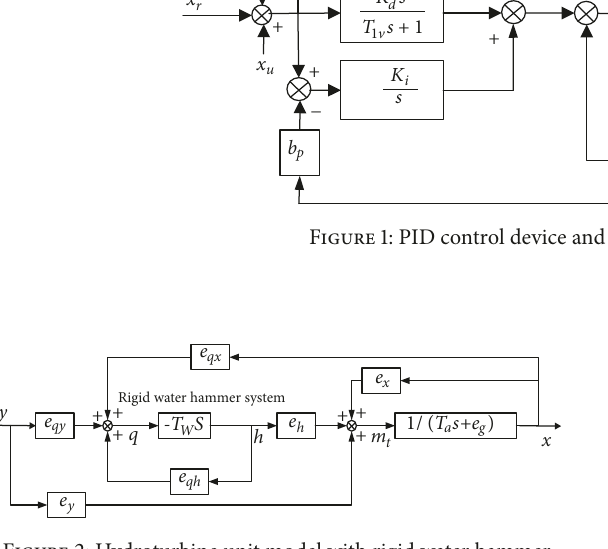
Figure 2: Hydroturbine unit model with rigid water